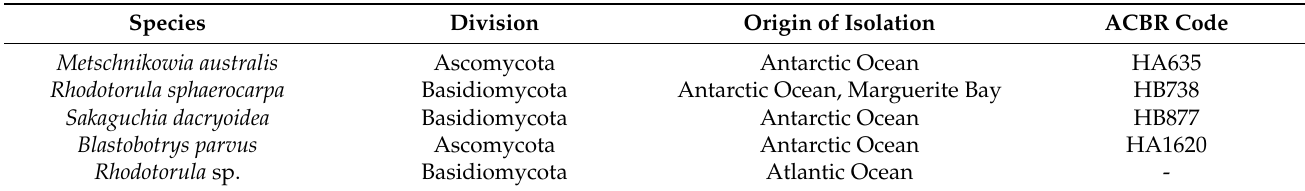
Table 1. Marine fungi used for the autofluorescence